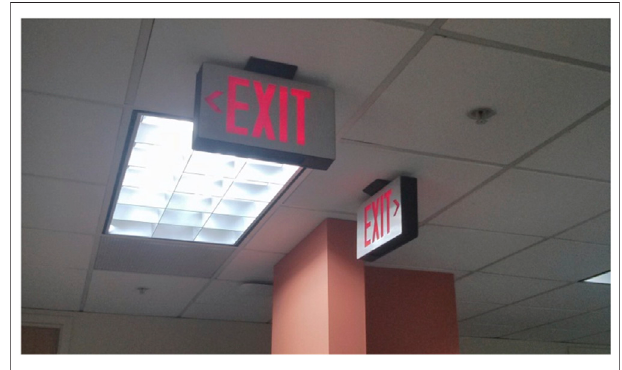
FIGURE 1 | Confusing exit